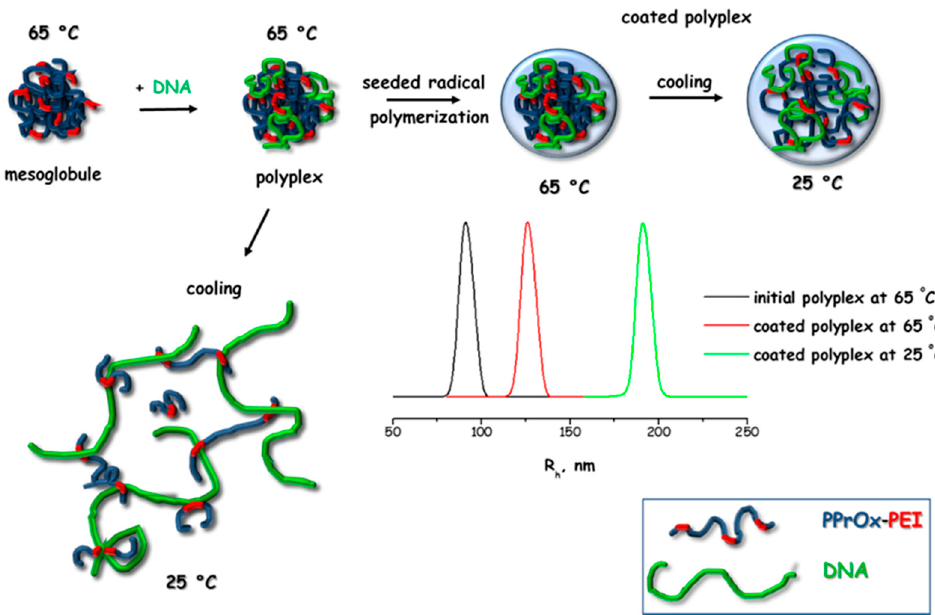
Figure 9. Schematic presentation of structural rearrangements of PnPOx–PEI polyplexes due to temperature variations and the proposed approach for their stabilization upon cooling. Adapted from Mees et al. as published by the American Chemical Society [41].